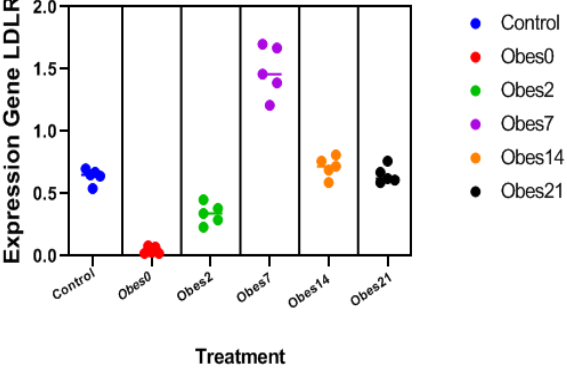
Figure 4. LDLR gene expression, p < 0.05 There was a significant difference.